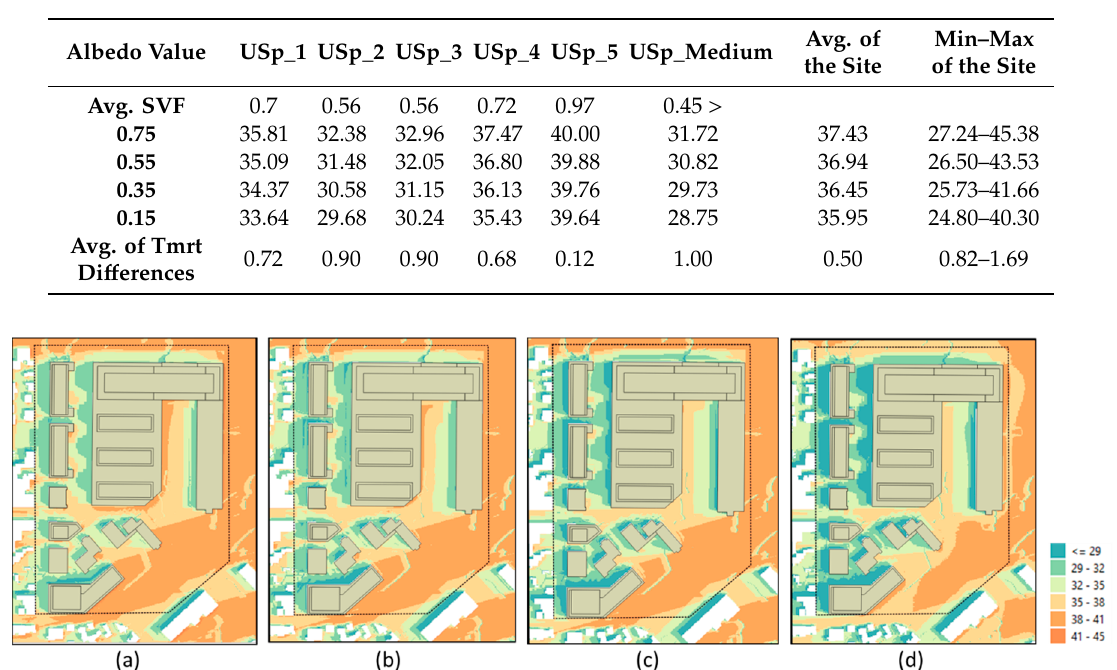
Table 2. The average daytime Tmrt (°C) in different urban spaces when the wall surface albedo changes.